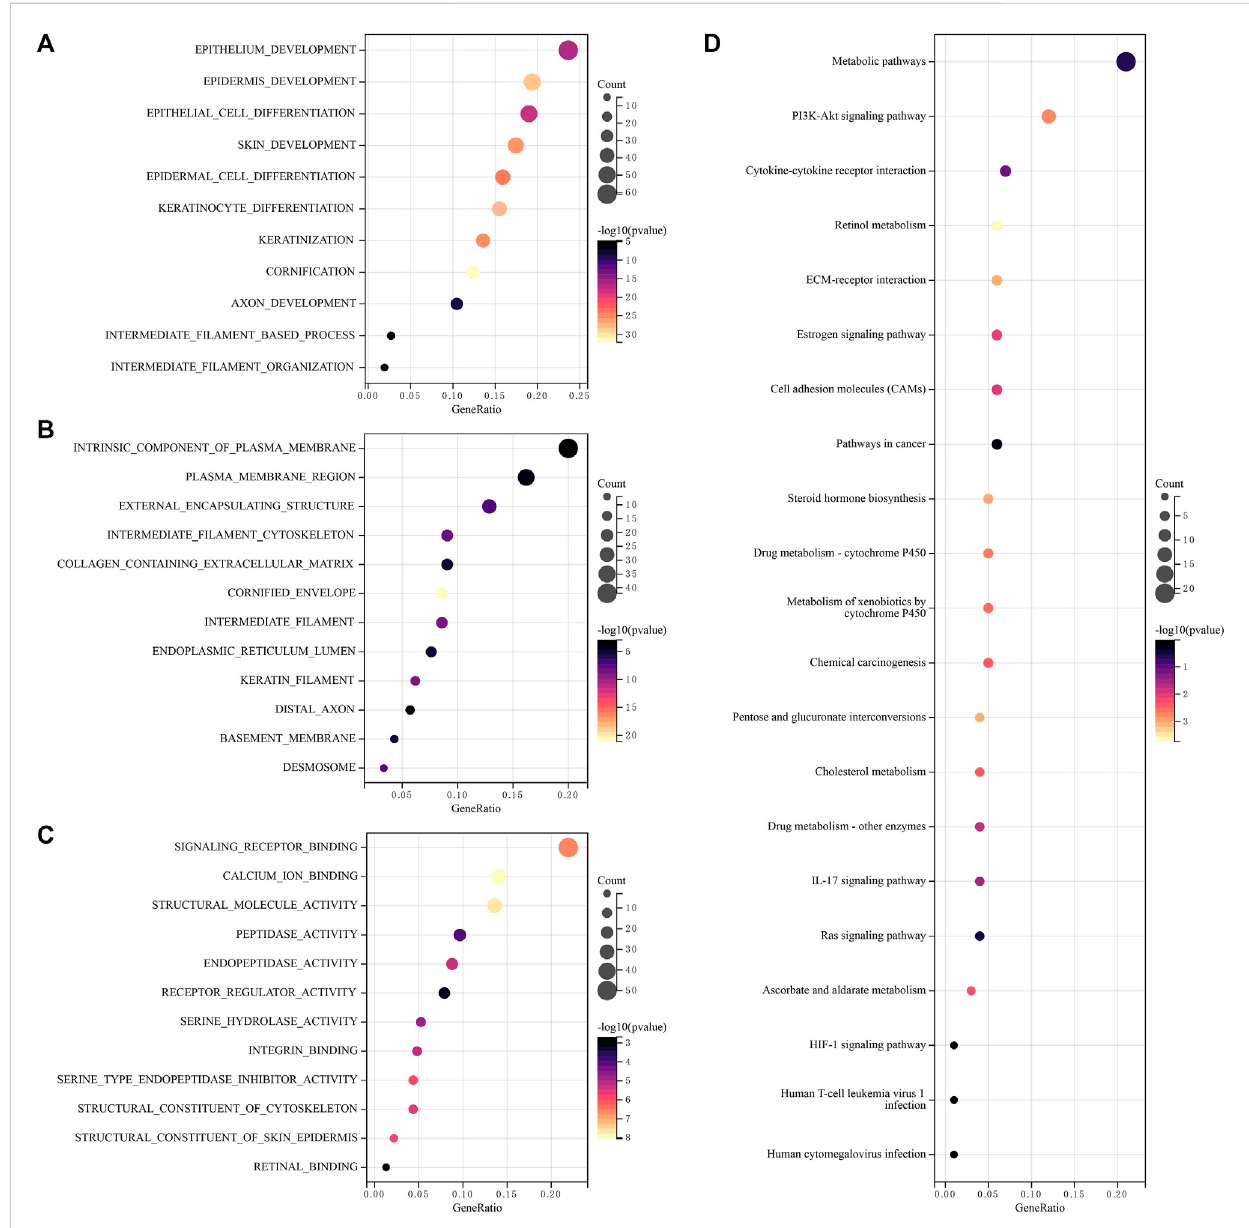
FIGURE 6 Functional enrichment analysis of lncRNAs (A – C) Differentially expressed genes and lncRNAs were enriched in biological process GO terms (A) BP (biological pathway), (B) CC (cytological component), (C) MF (molecular function), (D) Differentially expressed genes and lncRNAs were enriched in the KEGG pathways. GO, gene ontology, KEGG, Kyoto encyclopedia of genes and